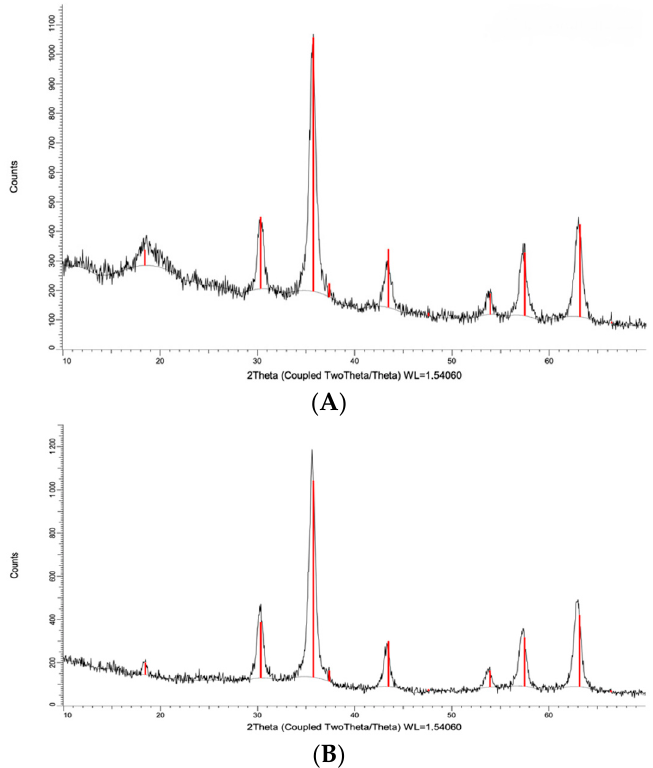
Figure 6. ( A ) The XRD patterns of the β -CD-EPI polymer-modified Fe 3 O 4 nanoparticles, ( B ) Fe 3 O 4 nanoparticles. ( B ) Fe 3 O 4